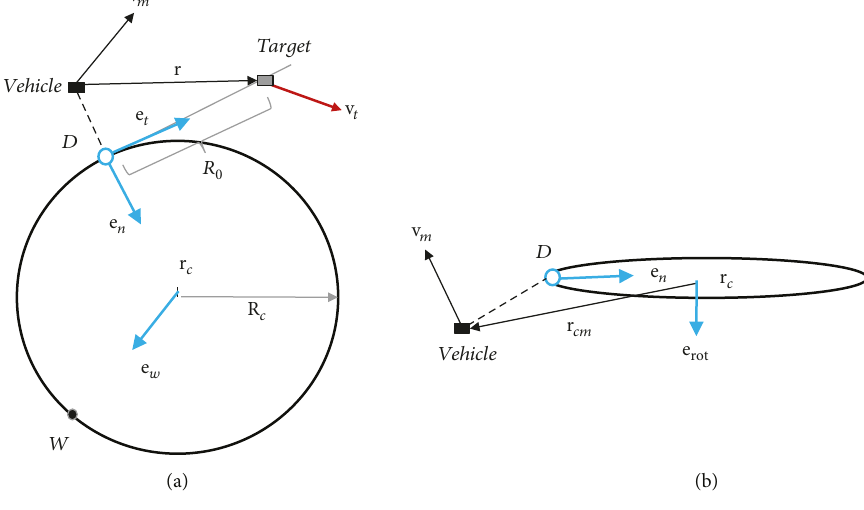
Figure 8: Circular path following ((a) top view, (b) side